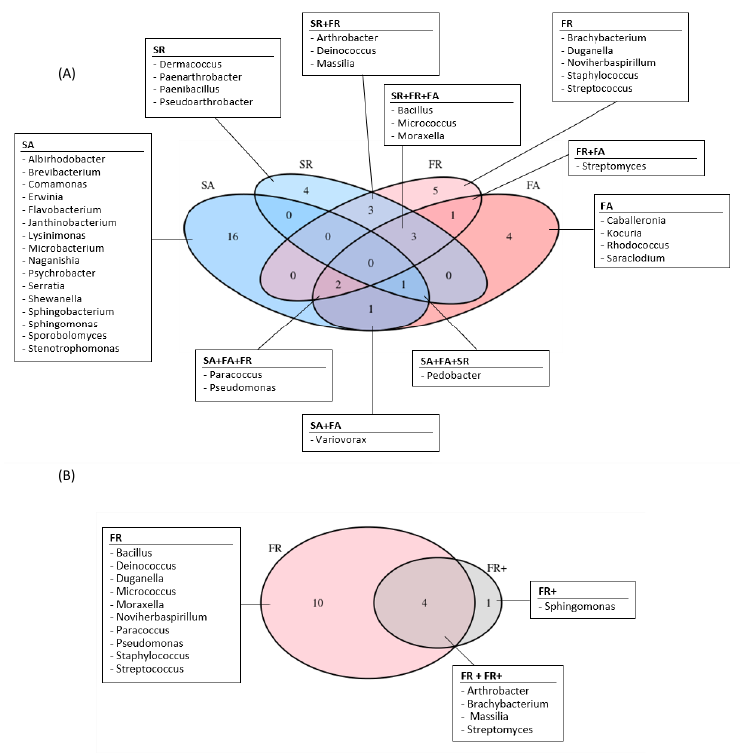
Figure 5. Venn Diagrams of the genera detected by cultivation. (A) Air and 1-year-old lava rock samples. (B) 1-year-old and 9-year-old lava rocks from Fimmvörðuháls. S: Surtsey, F: Fimmvörðuháls, A: Air, R: 1-year-old lava rocks, R+: 9-year-old lava rocks.